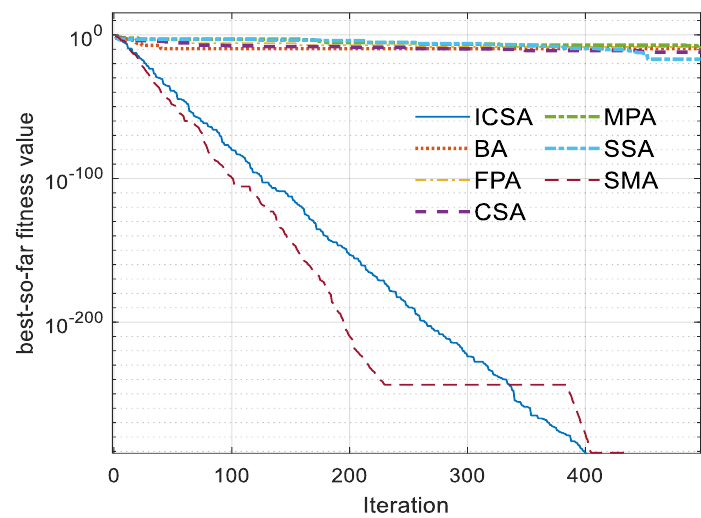
Figure 2. Convergence curve for F1.